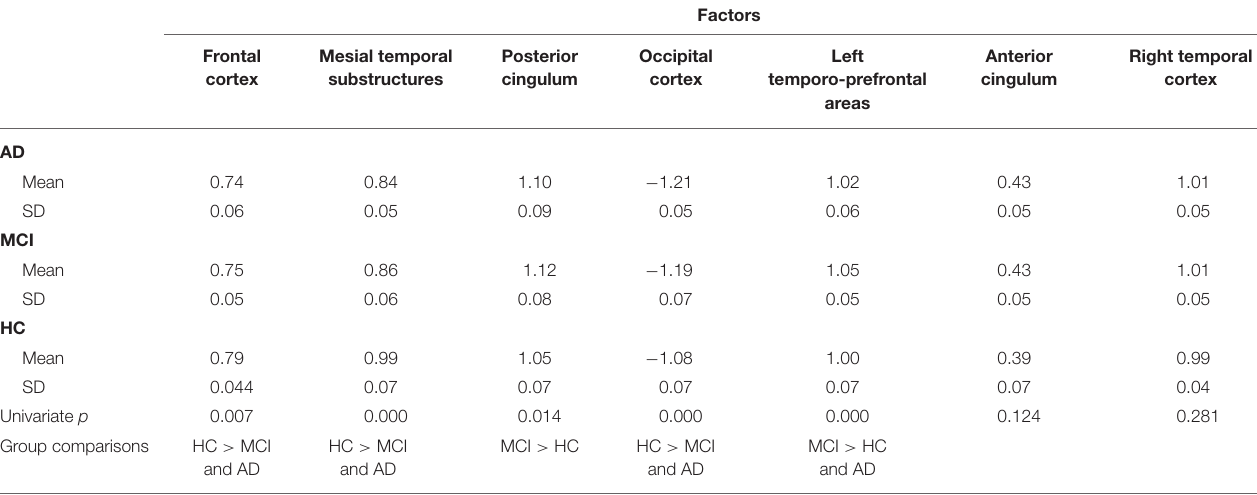
TABLE 3 | Means and standard deviations of the factor scales in patients with MCI or AD and the healthy